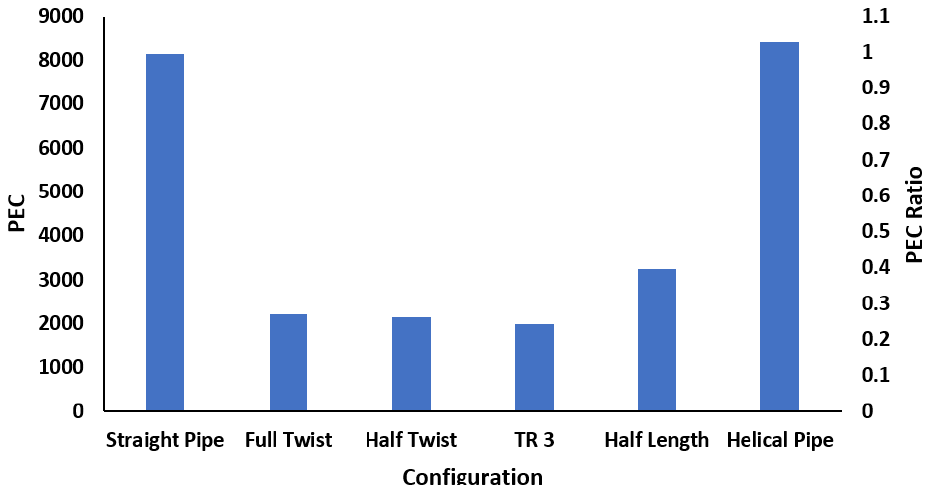
Figure 12. PEC of the various configurations.